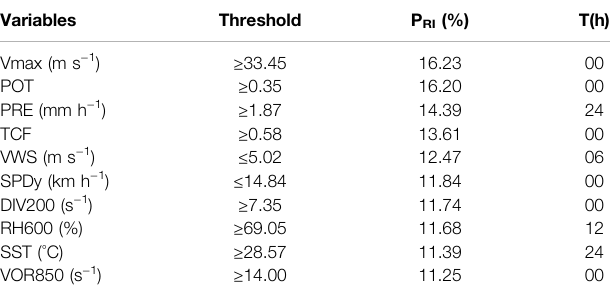
TABLE 4 | The threshold of each factor, the corresponding RI probability, and the lead time for TC RI over the MSC. Variables Threshold P RI (%)